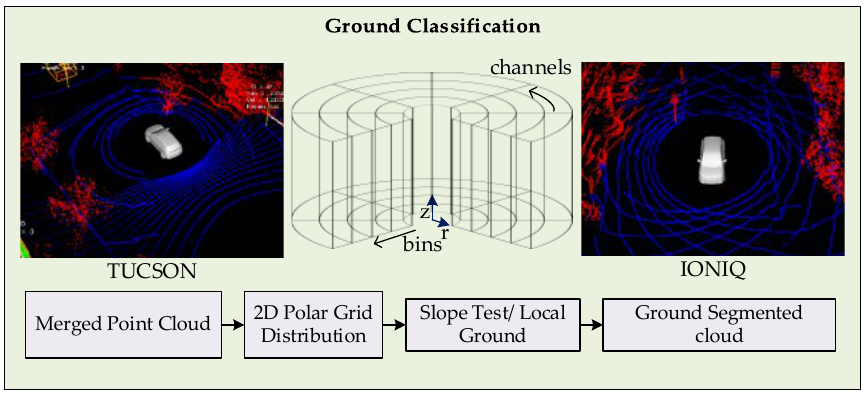
Figure 3. 2D Polar Grid-based Point Cloud Distribution and Ground Classification.